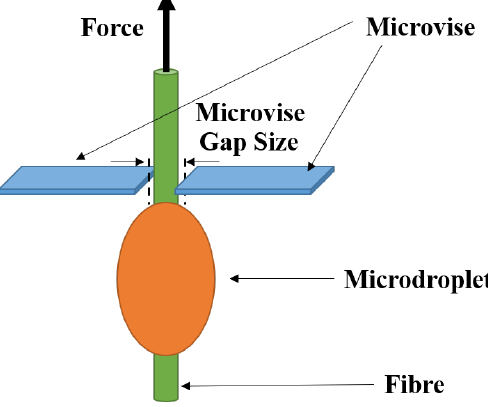
Figure 5. A schematic setup of the microbond